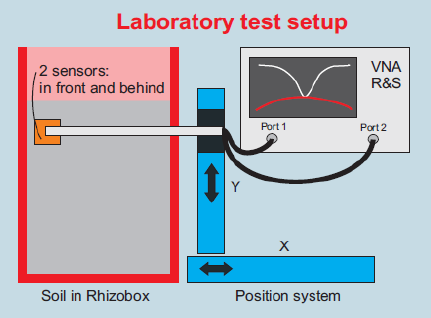
Figure 2. The block diagram of the system developed to measure S 21 (dB) of the soil moisture in the rhizobox, using the Vector Network Analyzer, in the microwave frequency range (4.6–5.0 GHz).